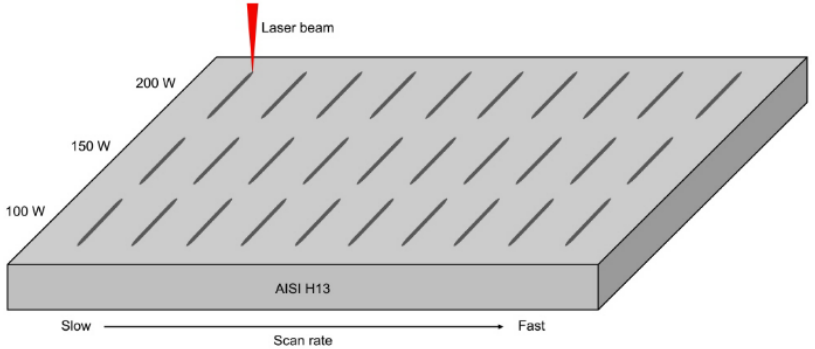
Figure 1. Schematic illustration of the single ‐ line formation test.